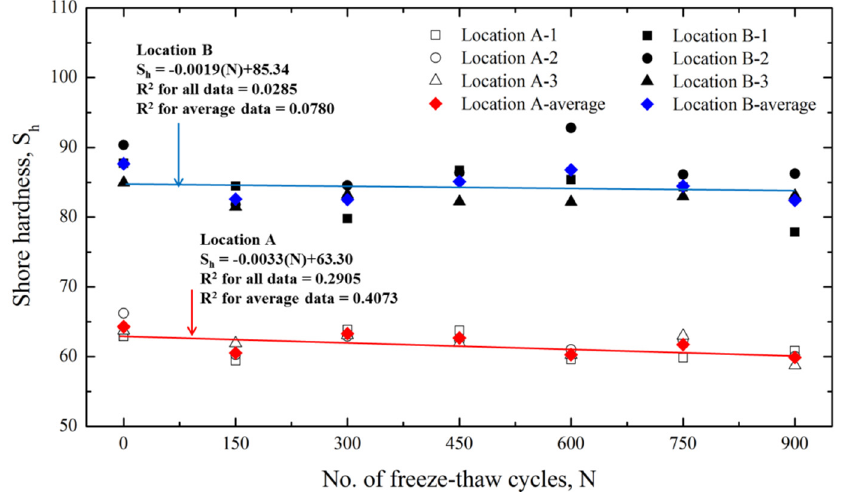
Figure 9. Shore hardness changes with increasing freezing-thaw cycle of Locations A and B.